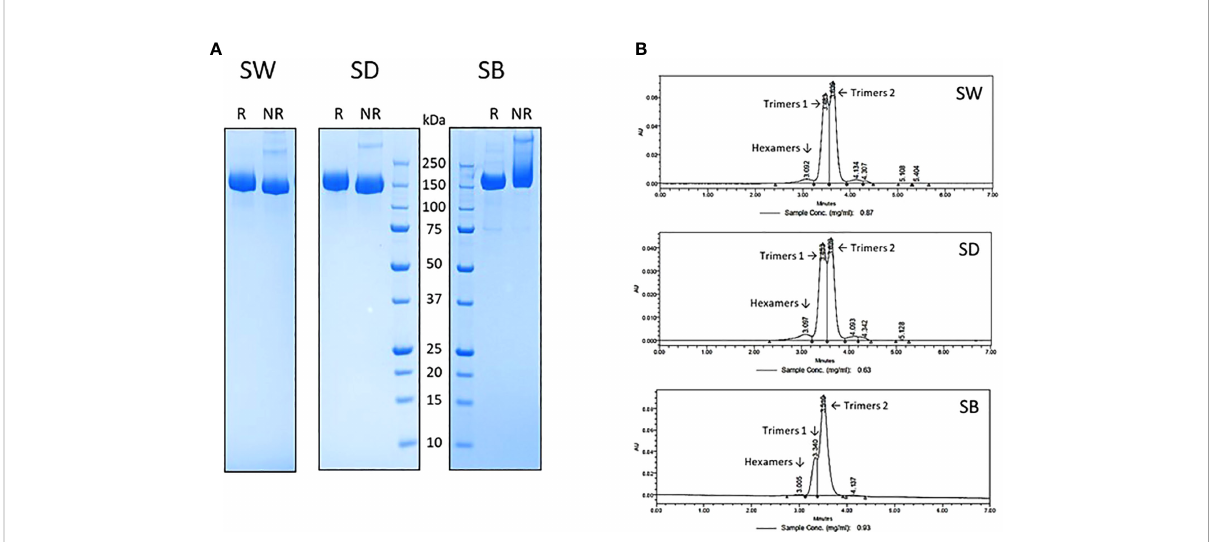
FIGURE 1 SARS-CoV-2 trimeric spike protein variants were produced in stable CHO pool and puri fi ed using a proprietary 3-step chromatographic process and analyzed by reducing (R) and non-reducing (NR) SDS-PAGE (A) and analytical size exclusion chromatography (B) as described in materials and methods. All spikes elute from the SEC-UPLC column as a mixture containing various amounts of Hexamers, Trimers 1 and Trimers 2 species. SW: ancestral Wuhan spike; SD: Delta spike variant (B.1.617.2); SB: Beta spike variant